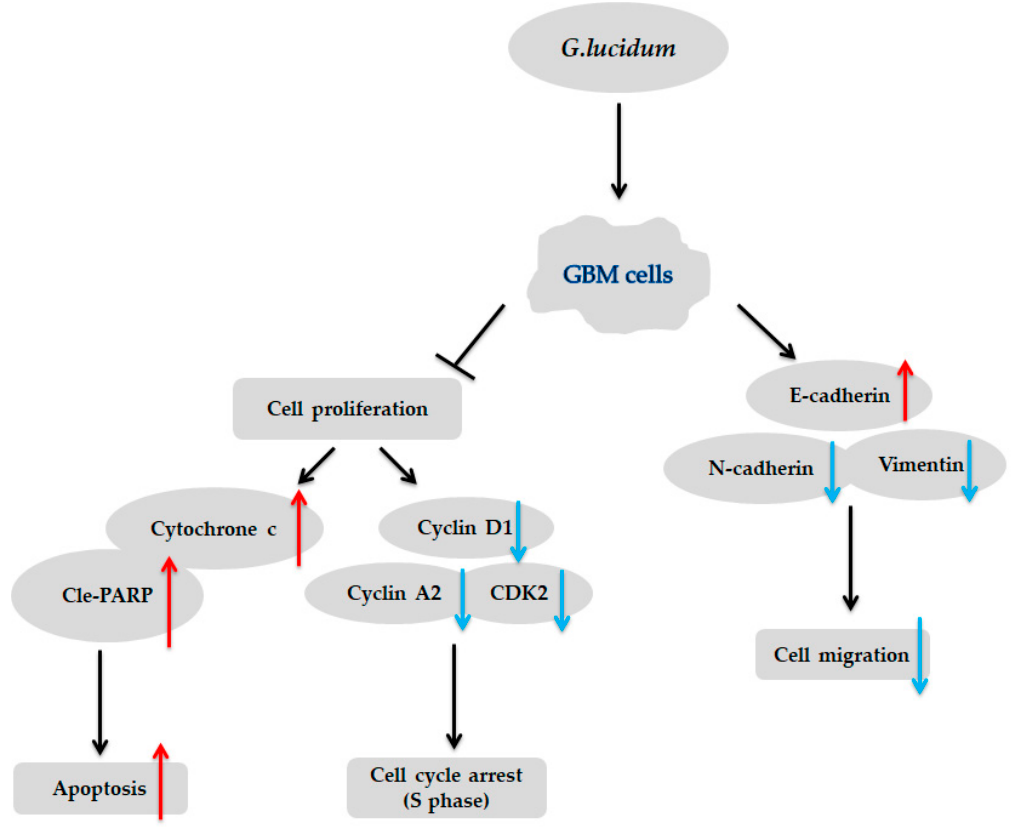
Figure 6. Proposed model for the mechanism of G. lucidum activity in human glioblastoma cells.